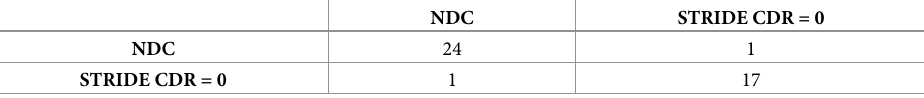
Table 6. AD-driven MCI aAB biomarkers are capable of identifying preclinical AD pathology in otherwise cogni- tively normal (CDR = 0) STRIDE patients.